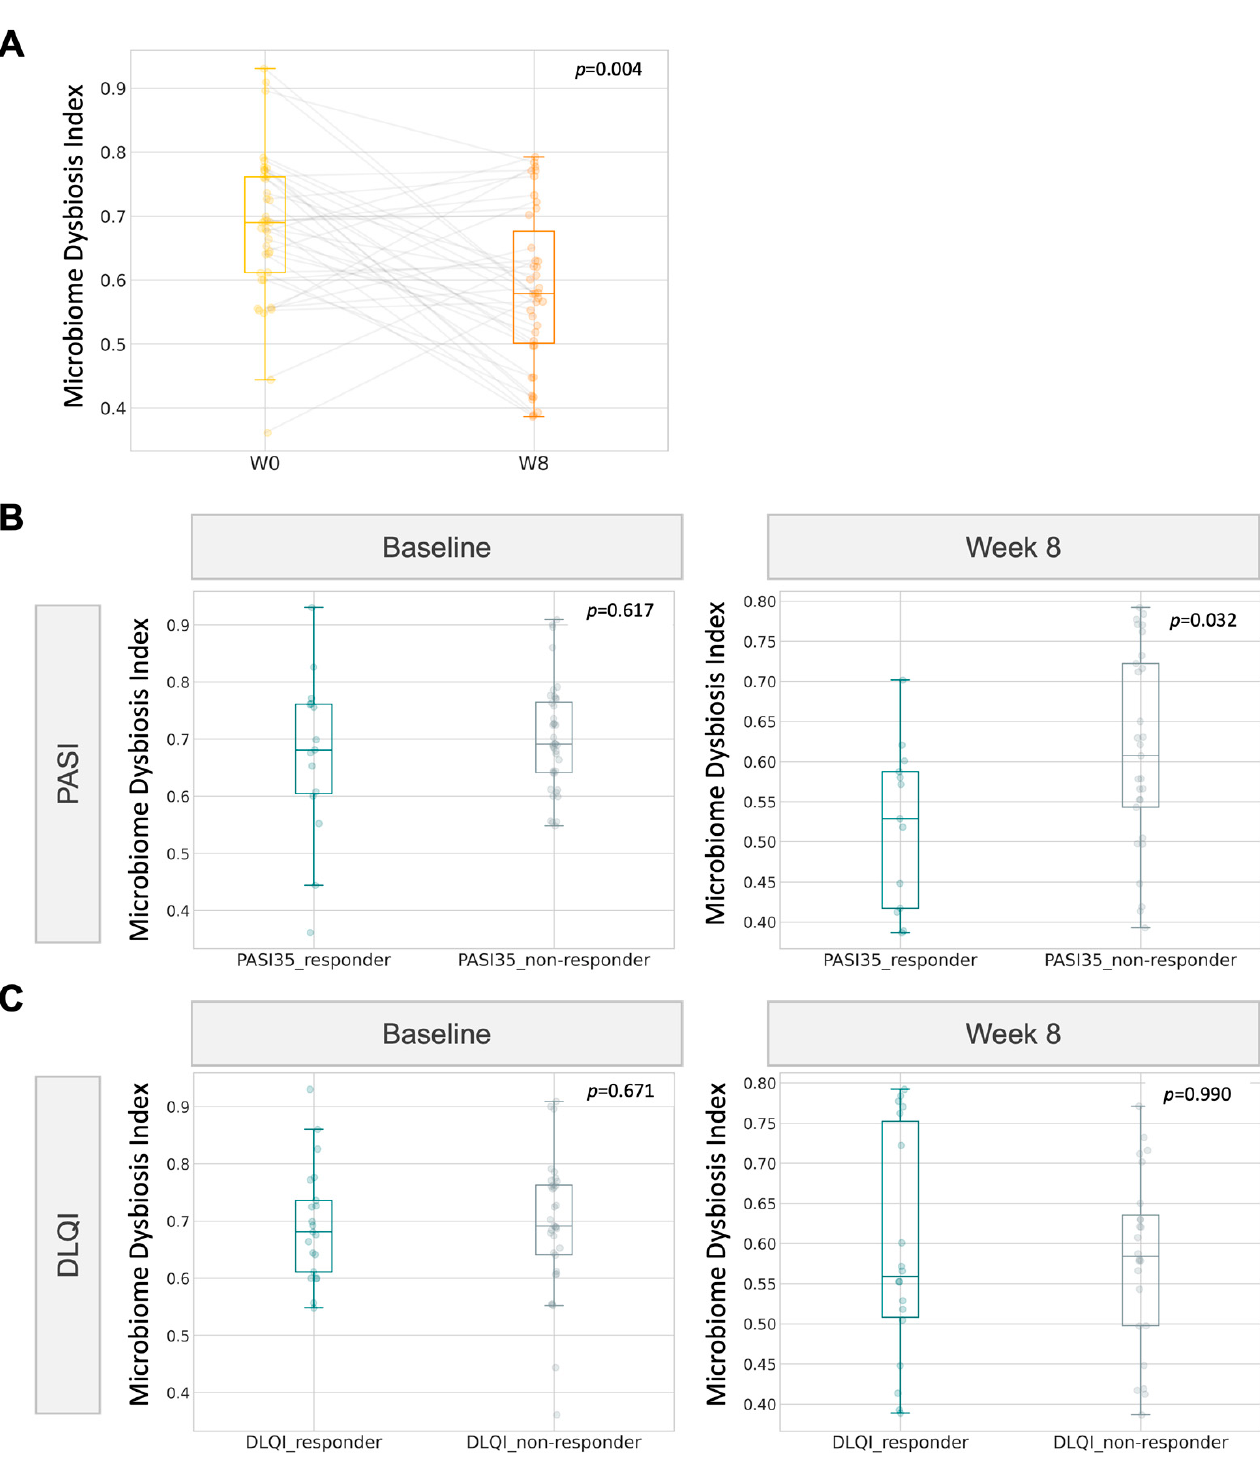
Figure 7. Correlation of gut microbiome dysbiosis index (MDI) with clinical improvement ( A ) Boxplot of MDI for psoriatic participants at baseline and at week 8. ( B , C ) MDI of responders towards 8-week probiotics treatment.